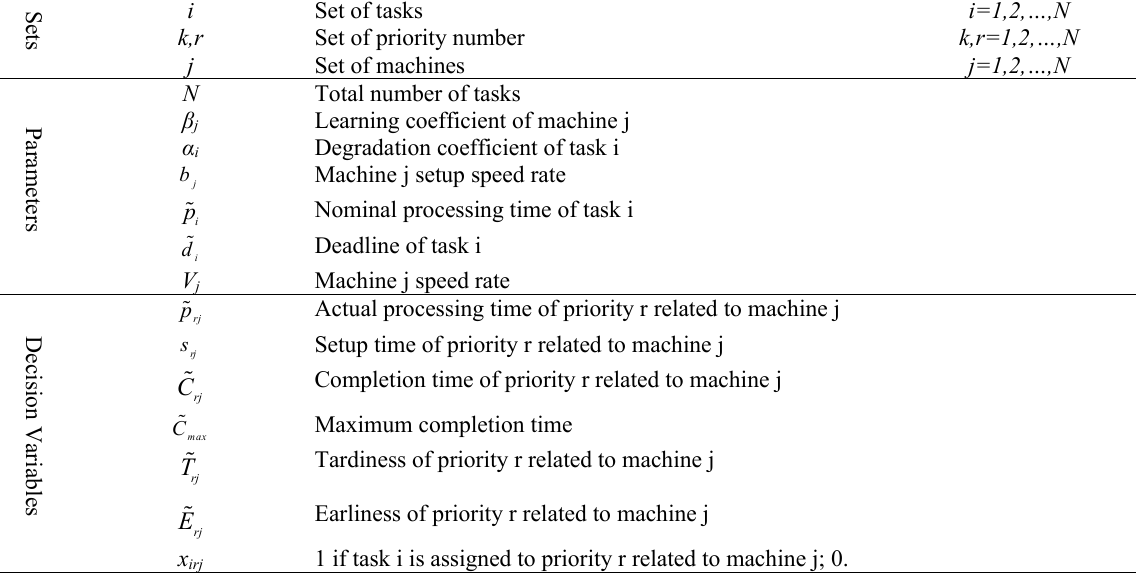
Parameters and Decision Variables of